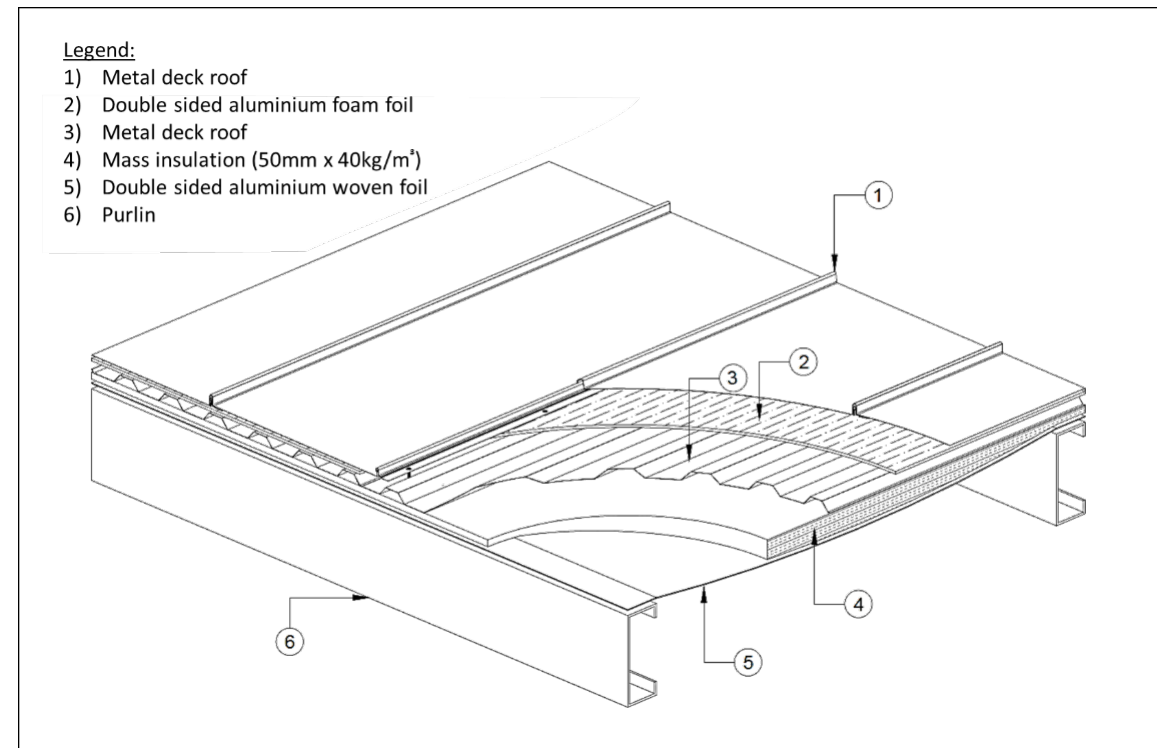
Figure 4: Double skin metal deck with mass insulation and RI (Source: Swissma Roofing